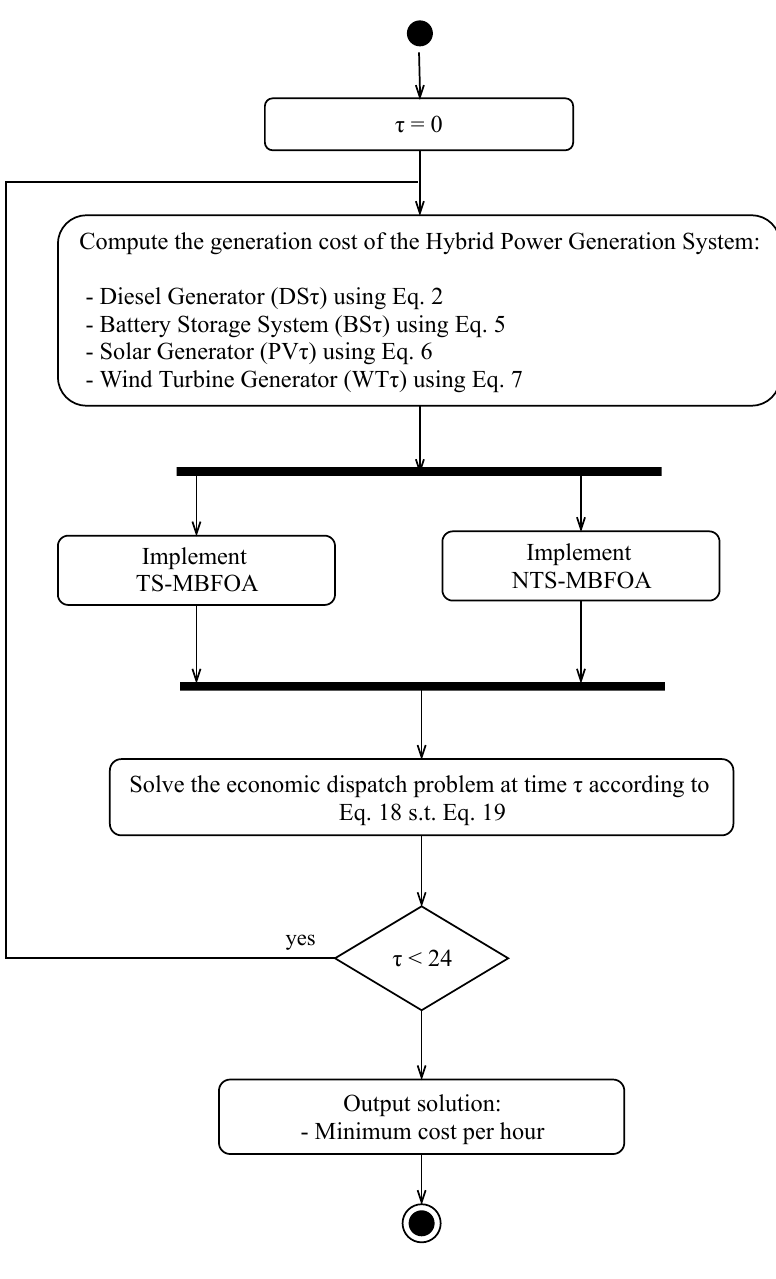
Figure 2. Isolated microgrid optimization